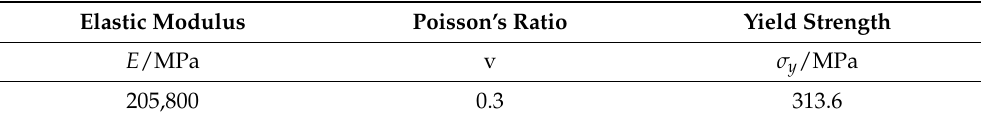
Table 2. Material parameters of the cracked